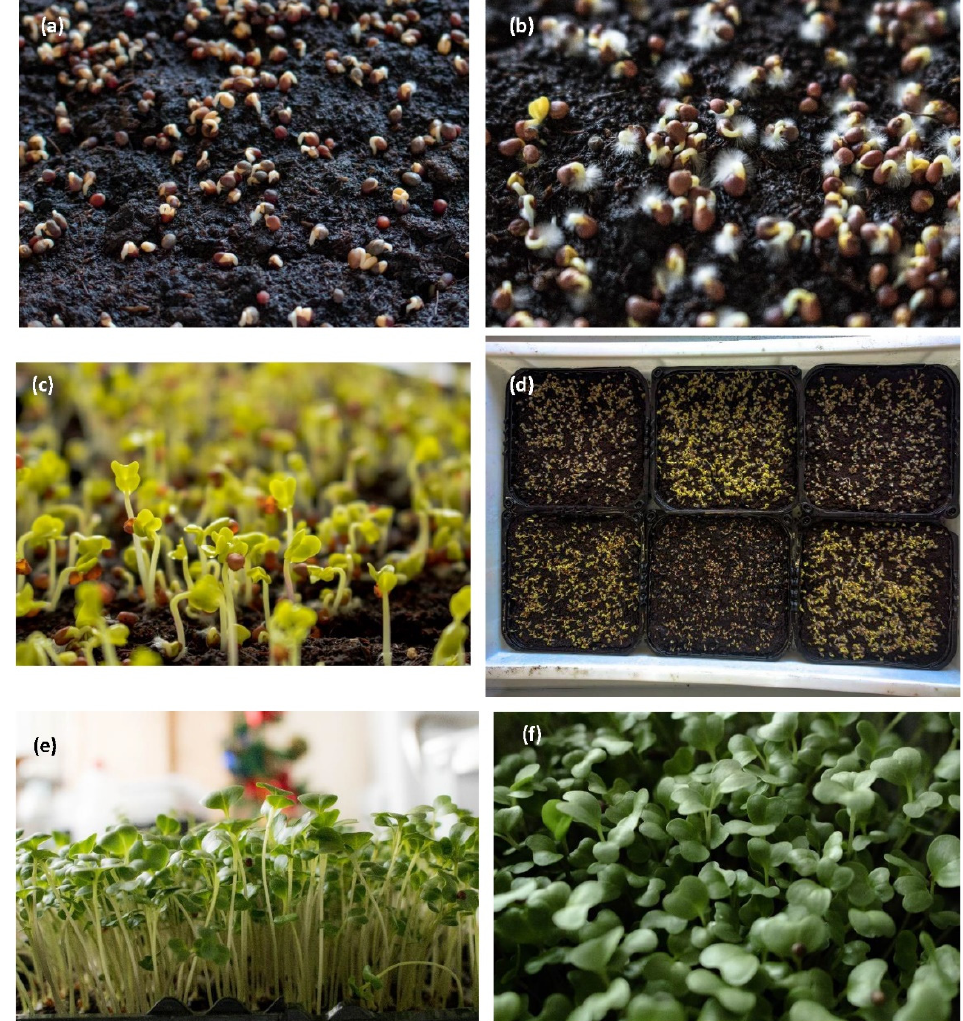
Figure 5. Rupture seeds integuments ( a ), radicles emission ( b ), hypocotyl emission and cotyledons distension ( c ), different seedling growth between Broccolo Natalino and Mugnoli ( d ), complete cotyledons distension of Broccolo Natalino ( e ), and complete cotyledons distension of Mugnoli ( f ). The photos were taken in the greenhouse.